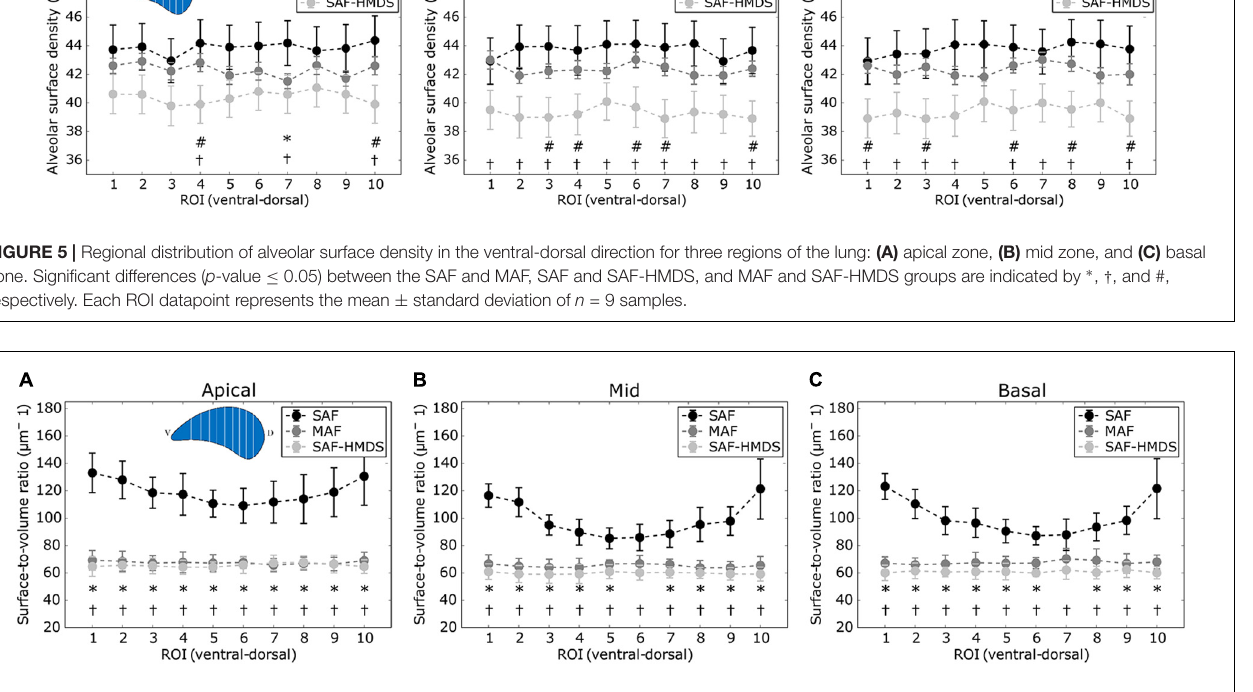
FIGURE 6 | Regional distribution of surface-to-volume ratio in the ventral-dorsal direction for three regions of the lung: (A) apical zone, (B) mid zone, and (C) basal zone. Significant differences ( p -value ≤ 0.05) between the SAF and MAF, SAF and SAF-HMDS, and MAF and SAF-HMDS groups are indicated by ∗ , † , respectively. Each ROI datapoint represents the mean ± standard deviation of n = 9 samples.